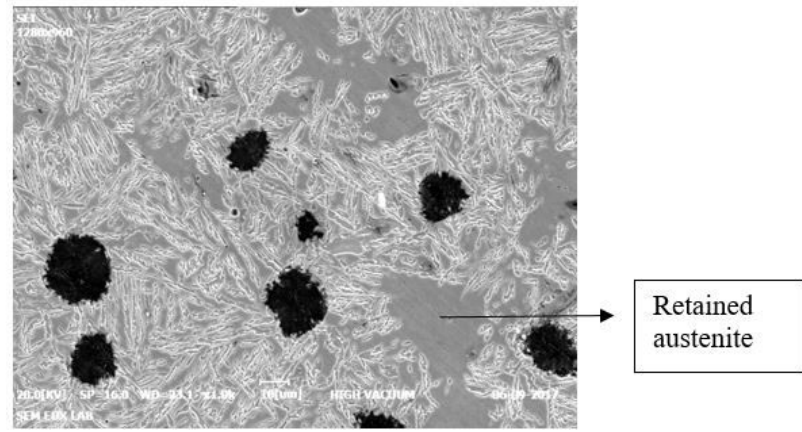
Figure 3. SEM image of ADI austenitized at 950ºC and austempered at 420ºC with 0.64 wt%